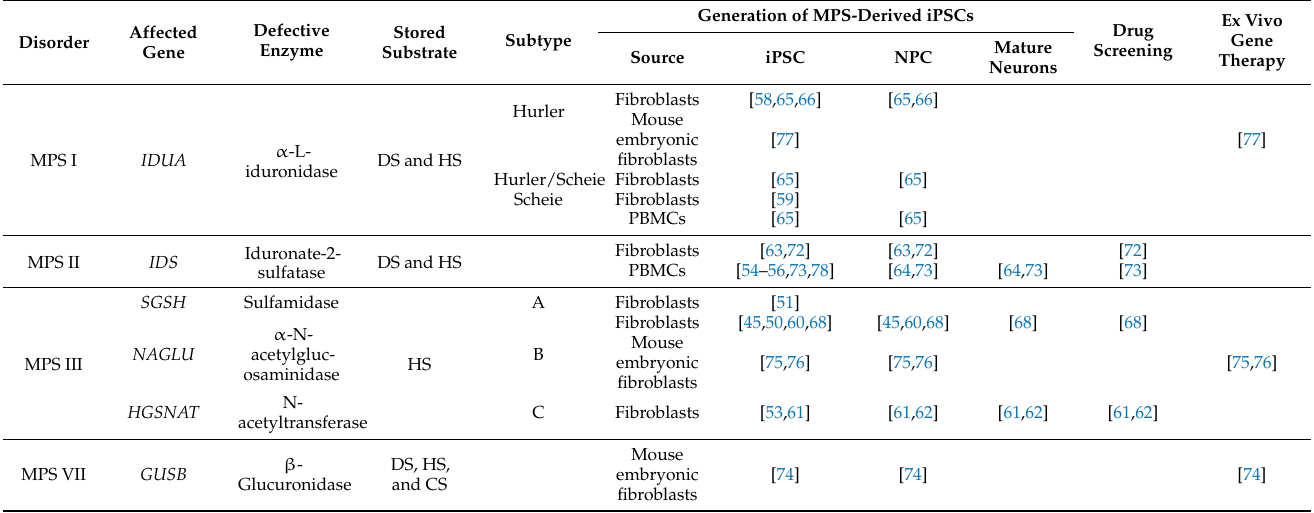
Table 1. A summary of the works performed in Mucopolysaccharidoses (MPSs) to date using induced pluripotent stem cell (iPSC)